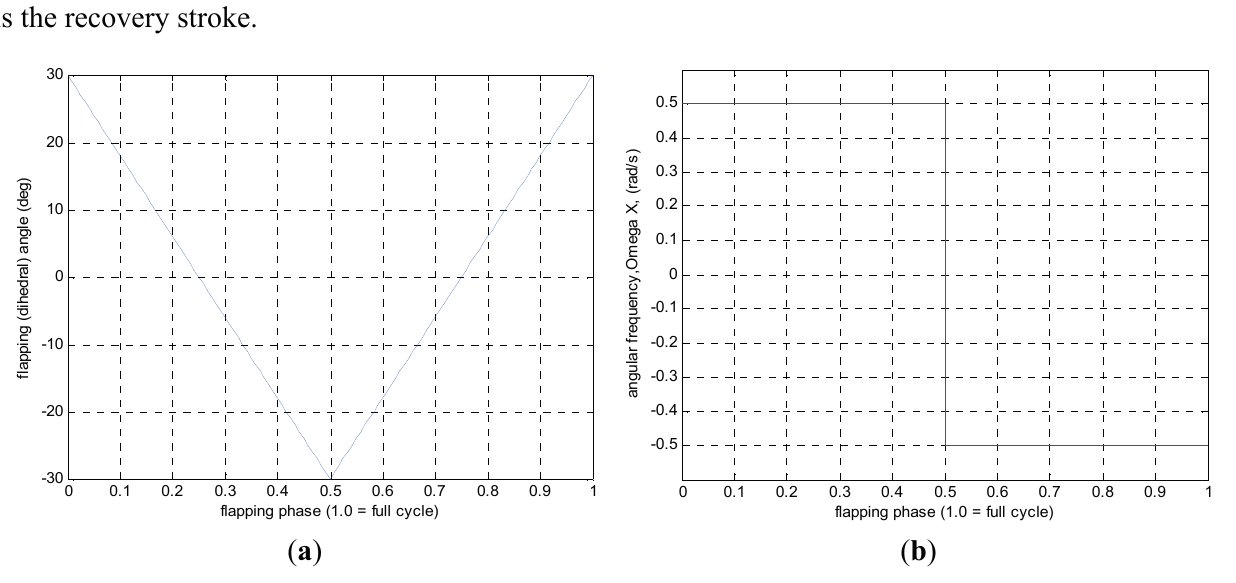
Figure 8. ( a ) Flapping patterns for simplified albatross flapping model about its body axis (chordwise, ω x ); and ( b ) the corresponding angular velocity, in each flapping cycle.